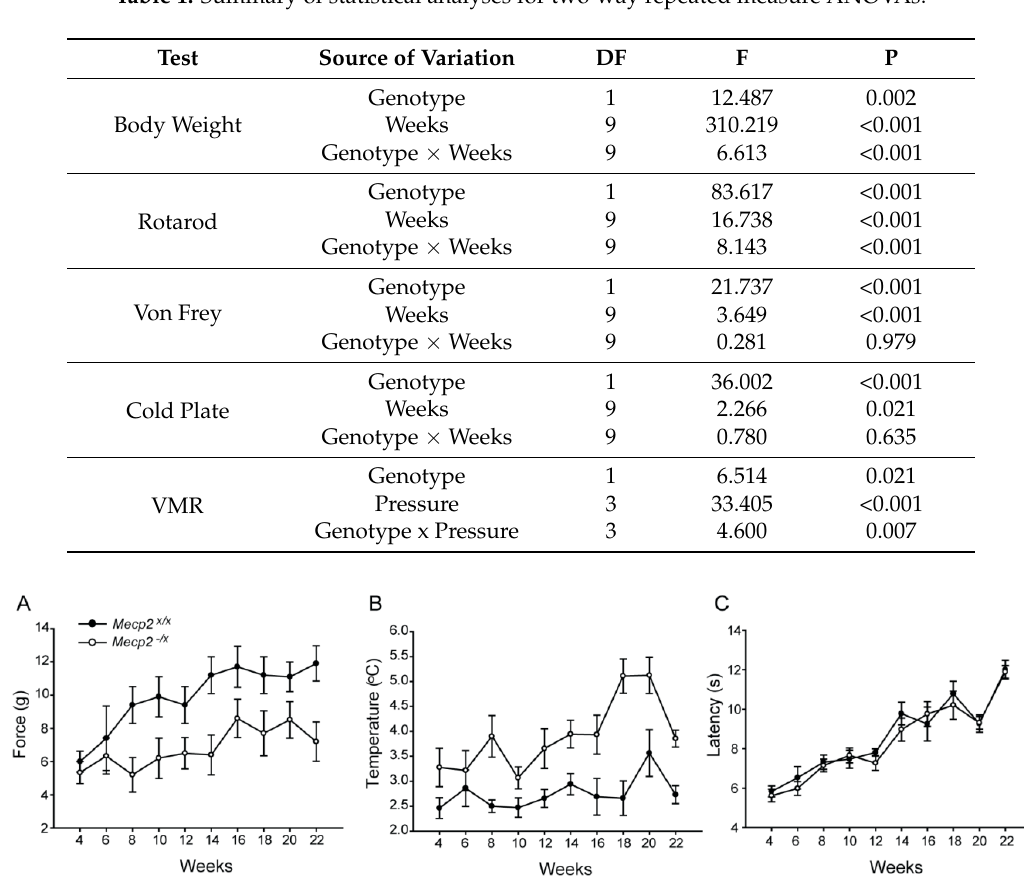
Table 1. Summary of statistical analyses for two-way repeated measure ANOVAs.